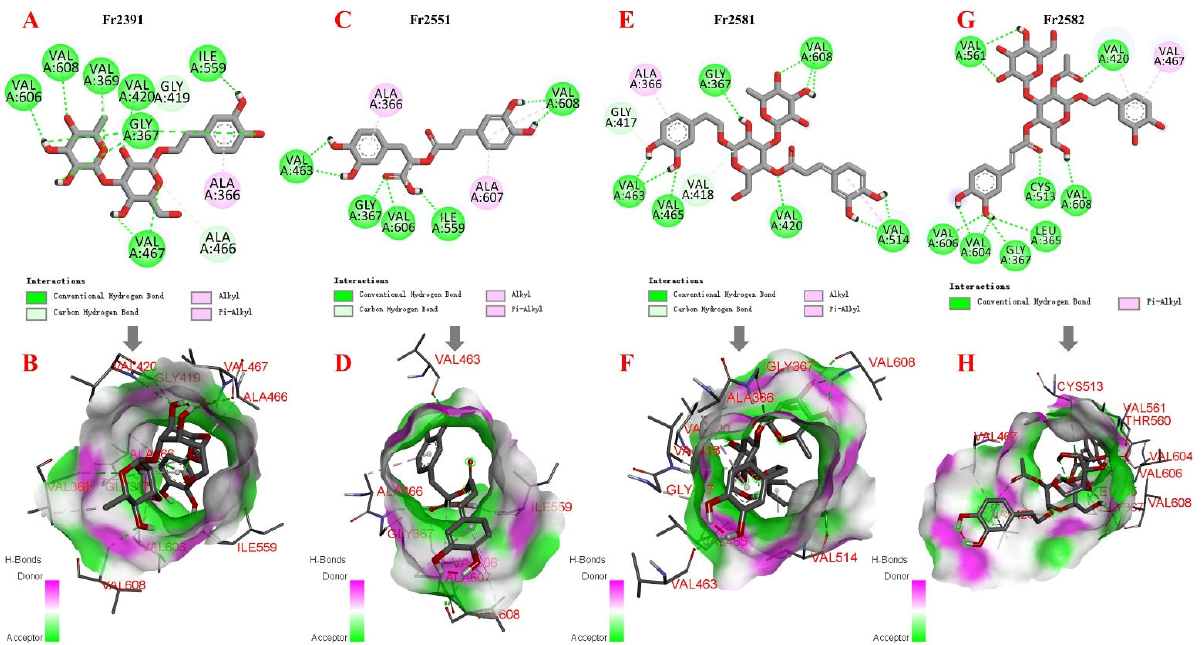
Figure 8. Molecular docking analysis of Nrf2 (PDB ID: 4IQK) during binding to Fr2391, Fr2551, Fr2581, and Fr2582. ( A , C , E , G , respectively) indicates the 2D interaction diagrams, with ( B , D , F , H ) showing bind ‐